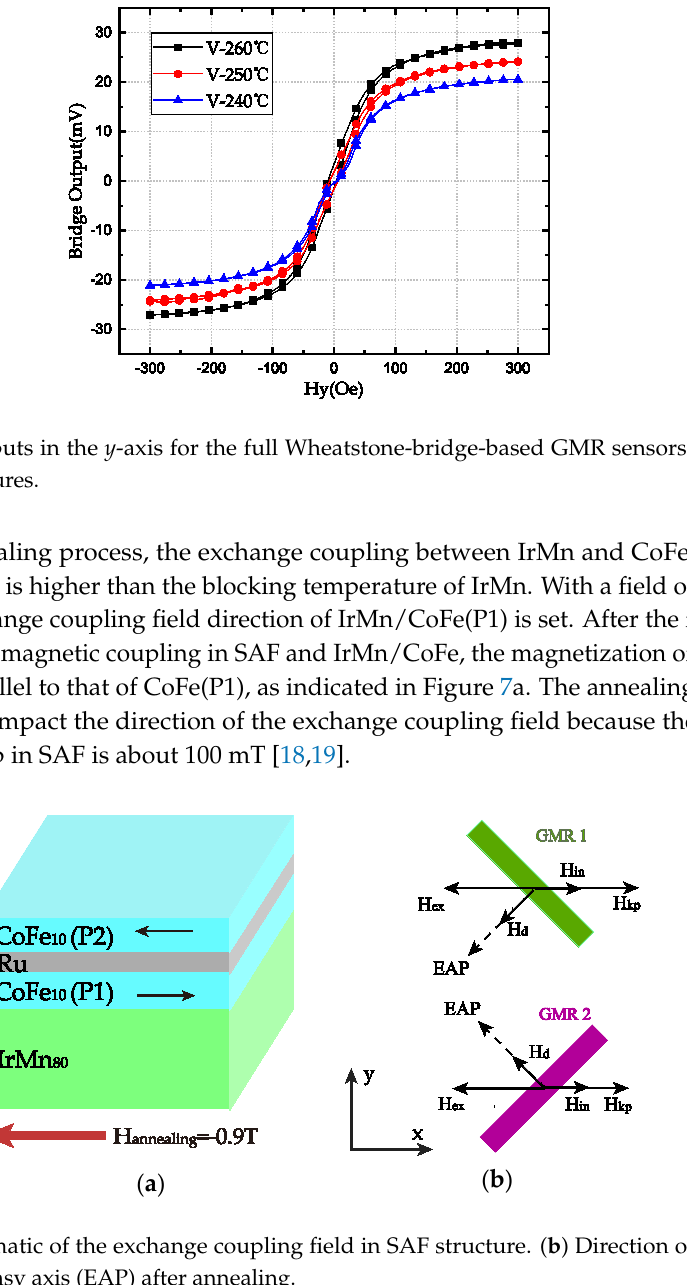
Figure 5. Bridge output as a function of the applied field direction.